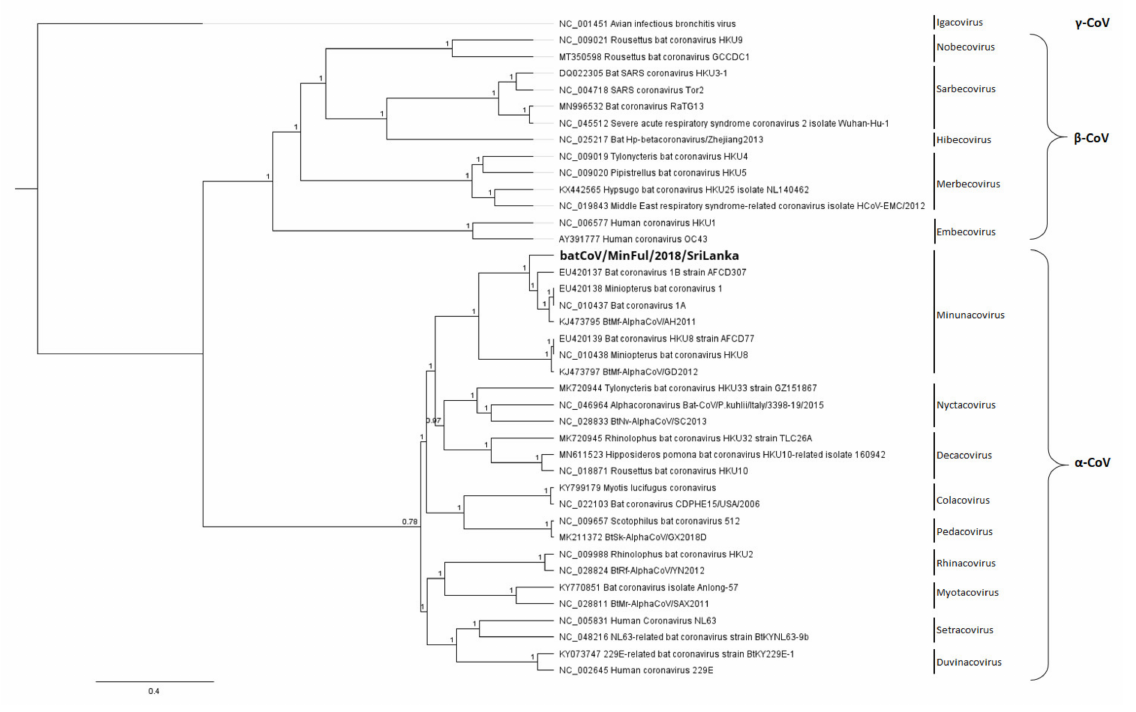
Figure 4. Phylogenetic tree based on an ORF1b nt alignment of the novel bat- CoV/MinFul/2018/SriLanka (bold) and selected CoV strains from different subgenera. The γ -CoV avian infectious bronchitis virus (NC_001451) was included as an outgroup for the calculation. The phylogenetic tree was calculated with the Bayesian algorithm, and 1 million generations were cal- culated with a subsampling frequency of 100 and a burn-in of 10%. Substitution model GTR was selected with a gamma-distributed rate variation.